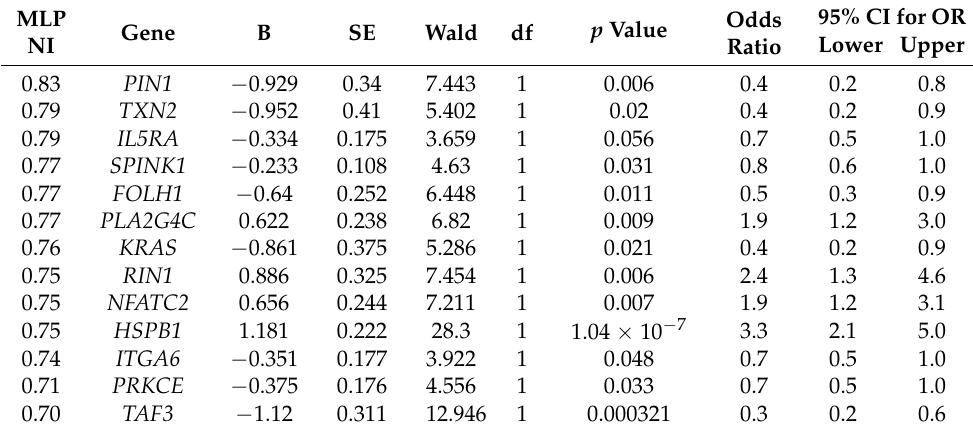
Figure 7. Multilayer perceptron between the top 10 genes and CSF1R expression levels (LLMPP data, all genes set). This figure shows the neural network diagram for the top 10 most relevant genes that predict the CSF1R expression. Table 8. Correlation between the gene expression of the top cancer panel genes of the multilayer perceptron (MLP) with CSF1R (high vs.